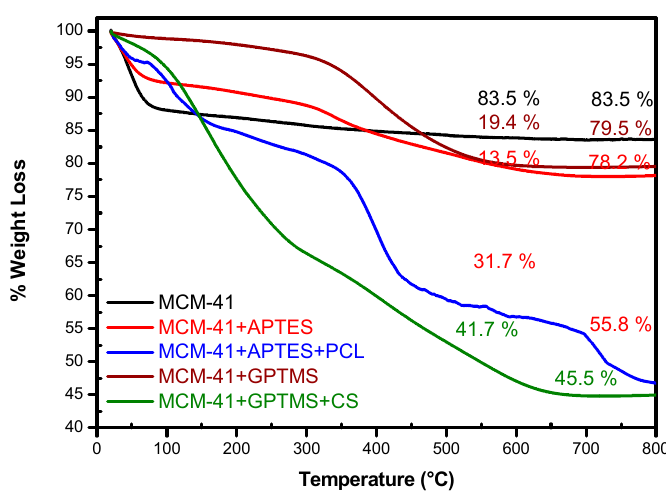
Figure 1. TGA analysis of pure MCM-41 and modified samples with APTES-PCL and GPTMS-CS. Table 1. TGA analysis of pure and functionalized MCM-41 samples.